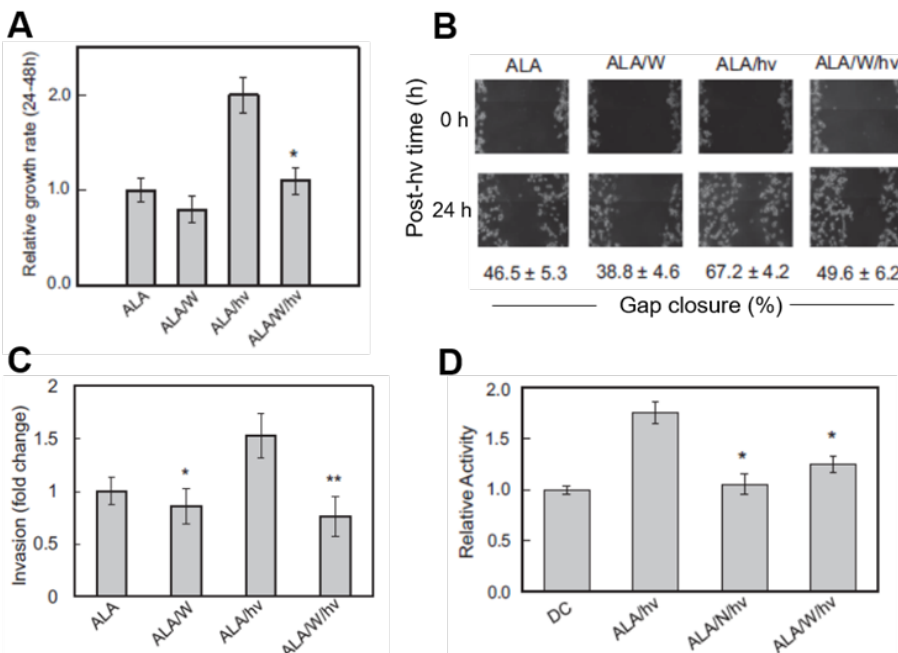
Figure 3. Enhanced aggressiveness of glioblastoma cells that survive a photodynamic challenge. U87 cells at ~40% confluence were sensitized with ALA-induced PpIX and irradiated (ALA/h ν : light dose/fluence ~1 J/cm 2 ). Where indicated, 25 µ M 1400W (W) or 1 mM L-NAME (N) was introduced immediately after irradiation and maintained as such thereafter. Dark controls (ALA or ALA/W) were run alongside. After 24 h of post-h ν incubation, any detached/dead cells were washed off and aggressive properties of remaining live cells were determined. ( A ) MTT-assessed proliferation rate; means ± SEM, n = 3, * p < 0.01 vs. ALA/h ν . ( B ) Gap-closure-assessed migration rate; means ± SEM, n = 3.( C ) Trans well chamber-assessed invasion rate; means ± SEM, n = 4, * p < 0.05 vs. ALA; ** p < 0.0001 vs. ALA/h ν . ( D ) Gel zymography-assessed MMP-9 activity; means ± SEM, n = 3, * p < 0.01 vs. ALA/h ν . Adapted from Reference [32].